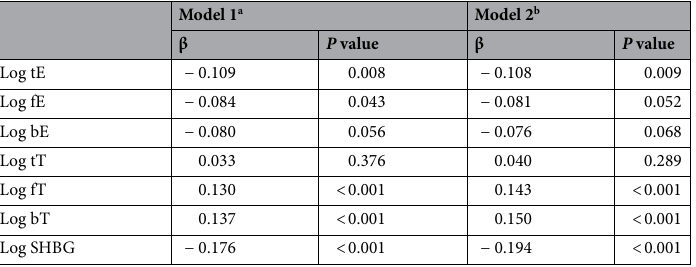
Table 4. Association of log-transformed sex hormones (independent variables) with uric acid (dependent variable) in 589 females (weighted sample size = 12,736,818) aged 47–56 years analyzed by weighted least squares regression. bE, fE or tE bioavailable, free or total estradiol, bT, fT or tT bioavailable, free or total testosterone; SHBG sex hormone-binding globulin. a Model 1: adjusted for age, ethnicity, body mass index (BMI, log-transformed), estimated glomerular filtration rate (eGFR), and self-reported health status plus lifestyle confounders including smoking status, alcohol consumption, and physical activity. b Model 2: adjusted for all variables in Model 1 plus self-reported comorbidities including hypertension, diabetes, hypercholesterolemia, coronary heart disease, stroke, sleep disorder, gout, and